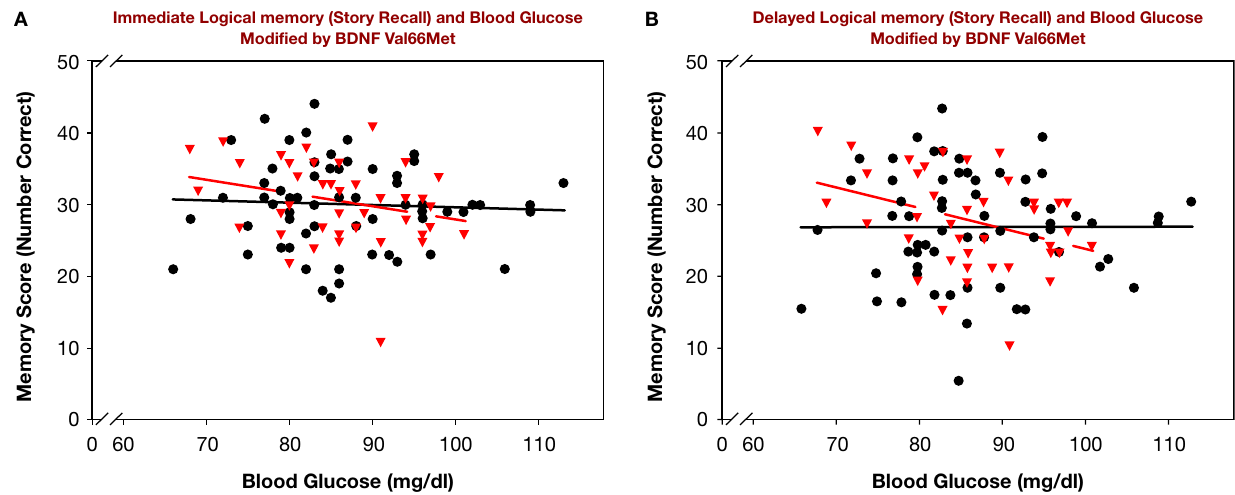
Figure 2 | Logical Memory (story recall) and blood glucose modifi ed by BDNF Val66Met genotype. BDNF Val66Met Met carriers (triangles, broken regres- sion line) are compared to BDNF Val homozygotes (circles, solid regression line). (A) Immediate recall. (B) Delayed